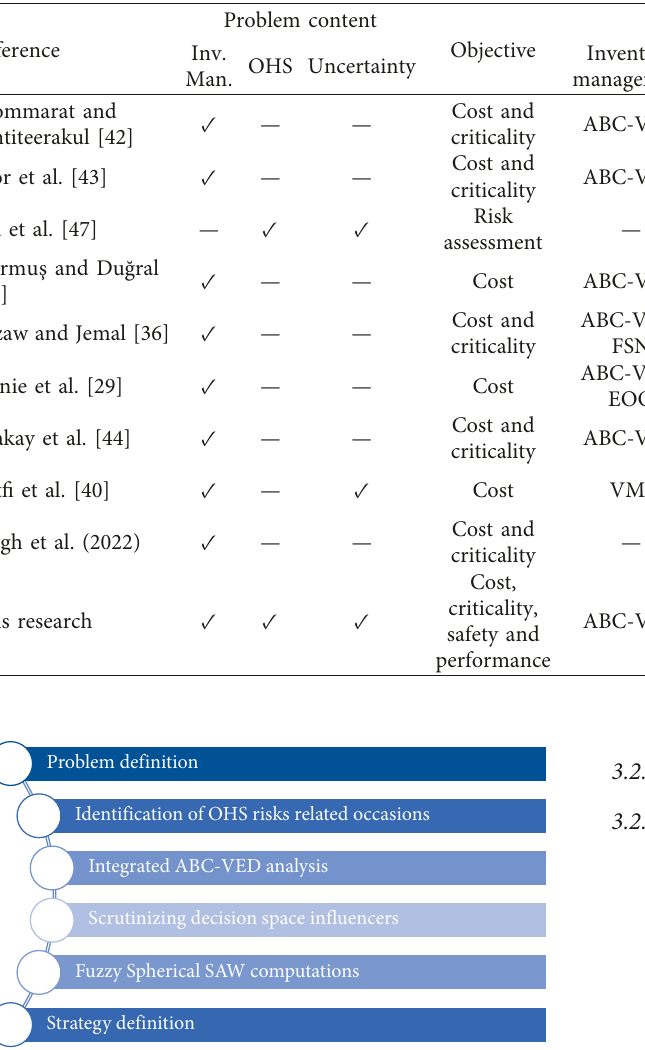
Figure 1: General operation flow of the proposed